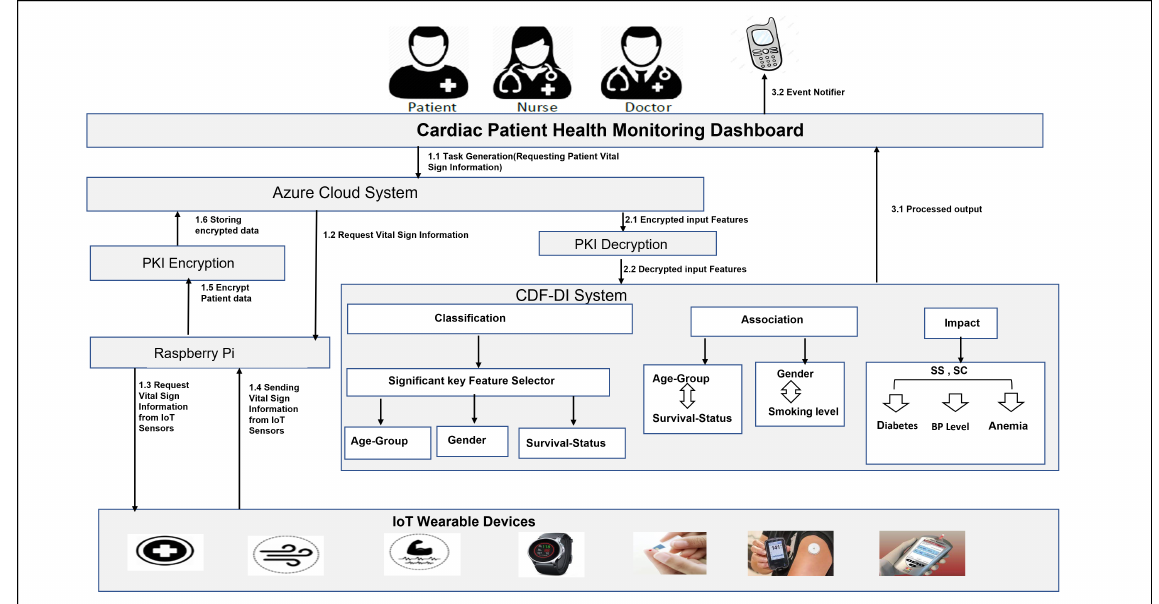
Figure 2. Workflow of IoT Based CDF-DI